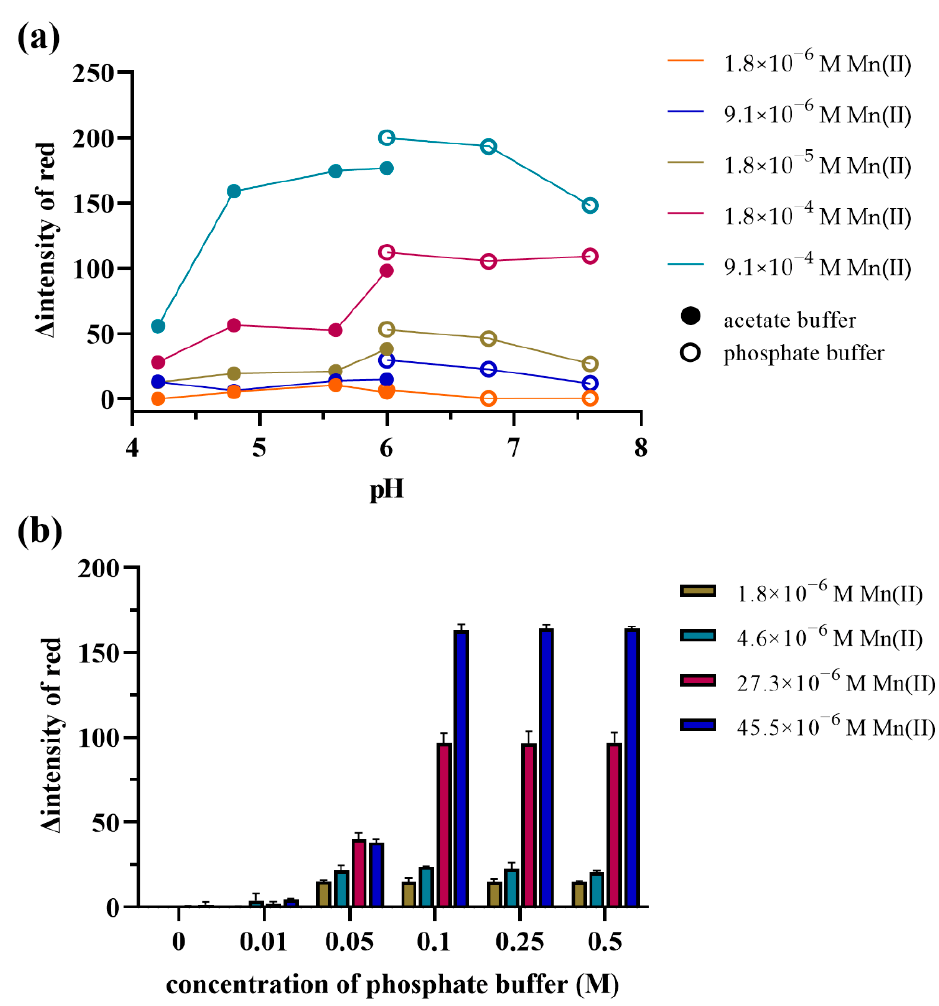
Figure 2. Oxidation of TMB by 4.3 mM KIO 4 with various concentrations of Mn(II)-catalyzed (M) under: ( a ) different pH levels of 0.1 M acetate buffer and 0.1 M phosphate buffer conditions ( b ) different concentrations of phosphate buffer pH 6.